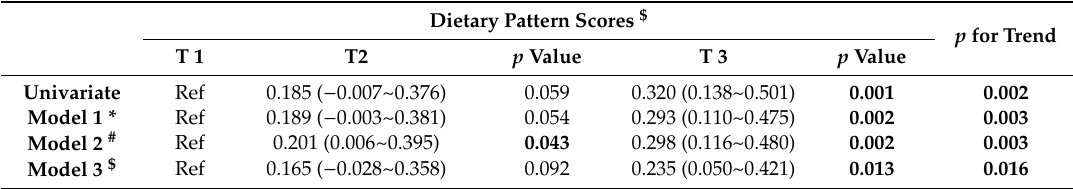
Linear regression of the relationship between tertiles of dietary pattern scores and log-transformed sCD163